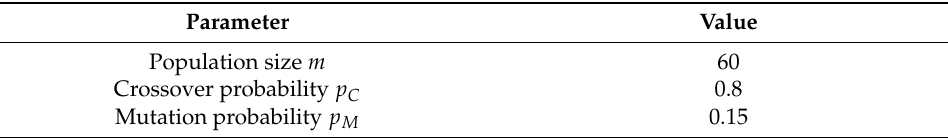
Table 1. FGGA algorithm parameters.